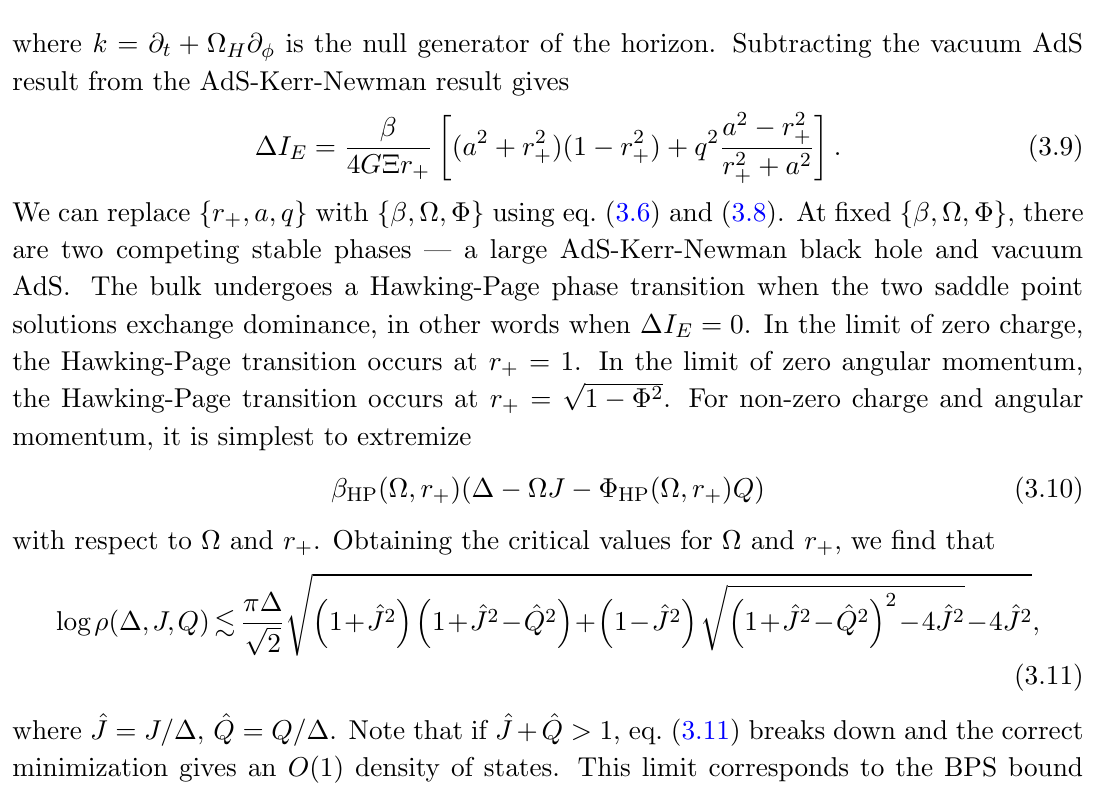
Figure 1. As an example, we plot our bound log (cid:26) ((cid:1) ; J; Q ) (thick) and the entropy of the cor- responding black hole (dashed) in d = 3 for (cid:12)xed black hole parameters, a = : 3 ; q = : 4. The two coincide at r HP and our bound is otherwise